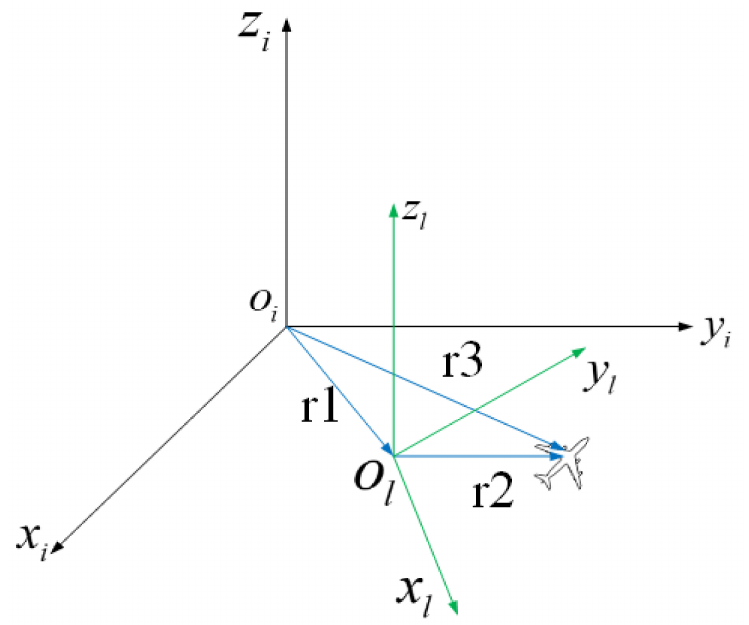
Figure 2. The conversion relationship between the launch inertial coordinate system and the J2000 inertial coordinate